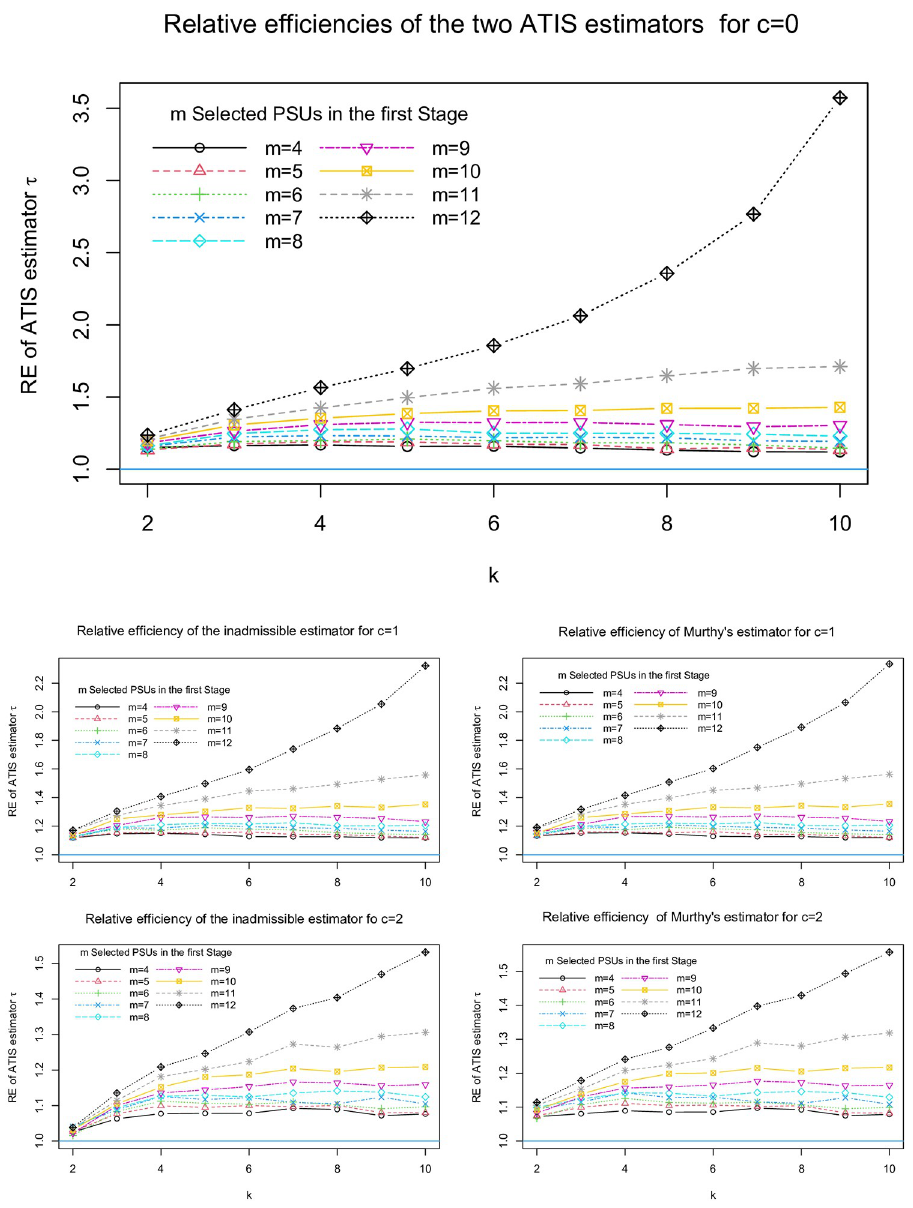
Fig 2. The buttercup population is partitioned into 12 PSUs of size 25 and the relative efficiency of Murthy’s and the inadmissable estimators of ATIS are computed for different values of m , k and c which are presented in 5